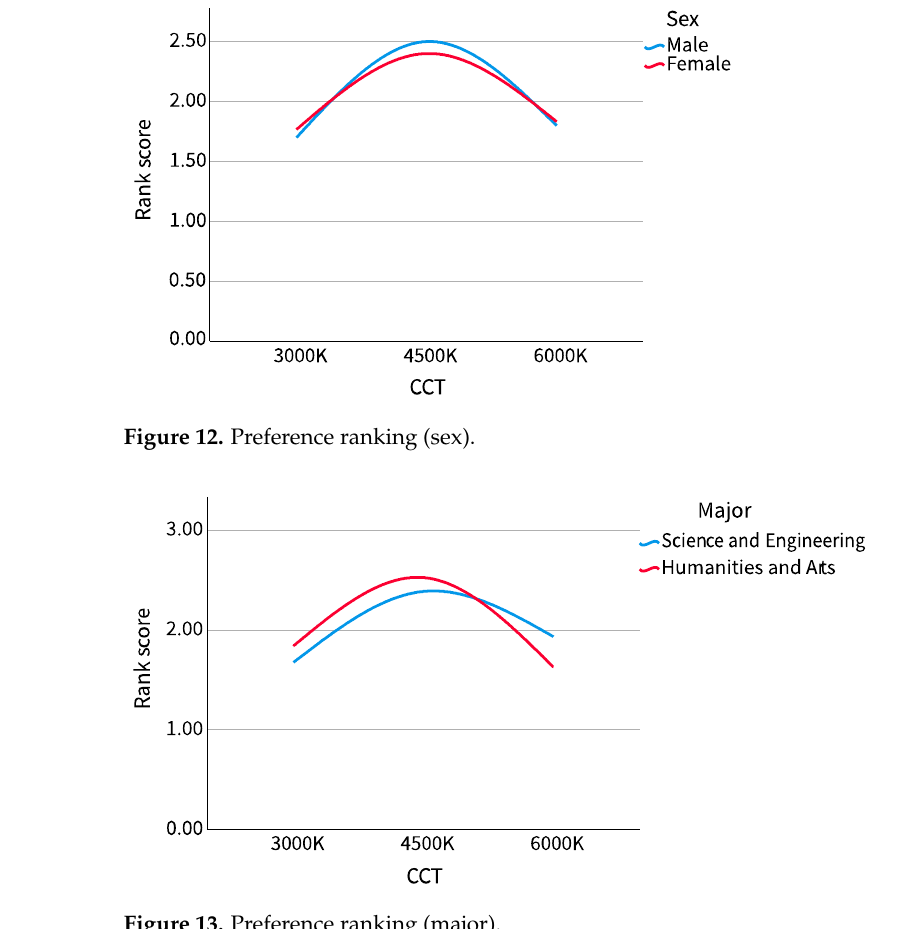
Figure 13. Preference ranking